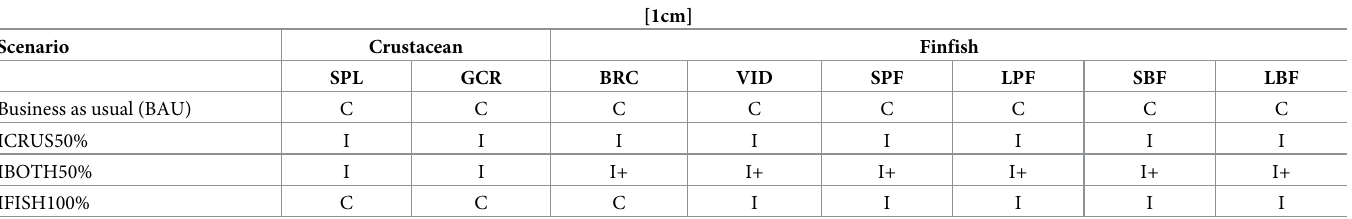
Table 3. Scenarios used to evaluate the effects of future fishing activity in the JFRE. C stands for current level of fishing pressure, I is the increase in fishing pressure and I + is the cumulative increase of fishing pressure for both types of artisanal